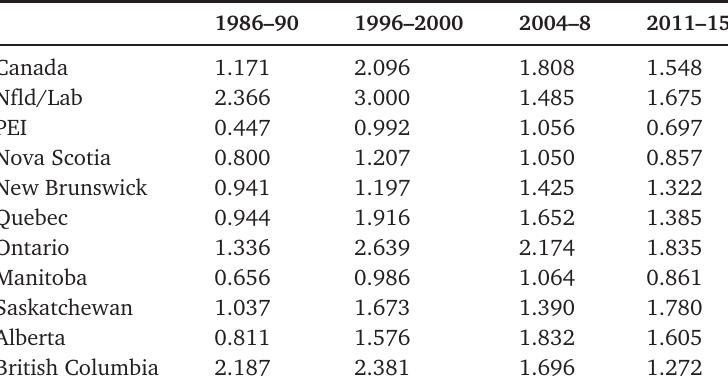
Table 6. Average Ratio of International to Interprovincial Exports Canada and Provinces, Current